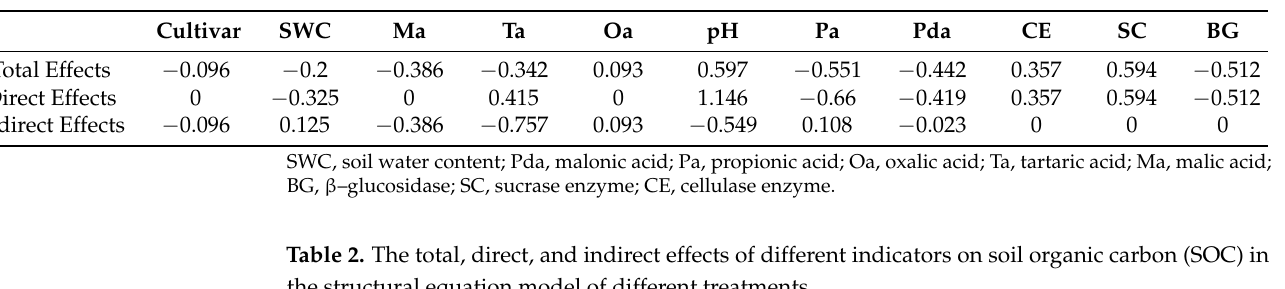
Table 1. The total, direct, and indirect effects of different indicators on soil organic carbon (SOC) in the structural equation model of different cultivars.